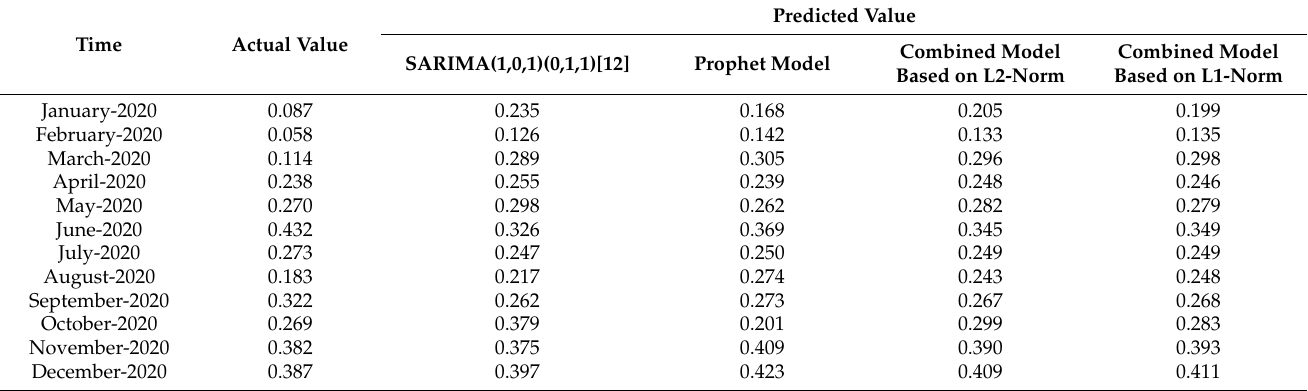
Table 2. Comparison of predicted values and actual values from January to December 2020 (per 100,000